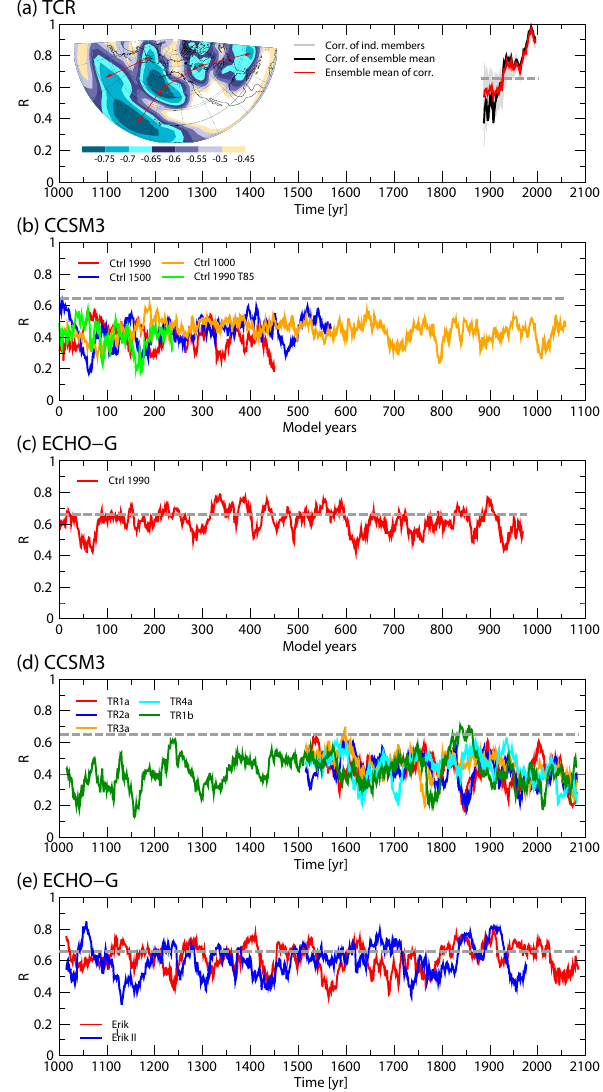
Fig. 4. As Fig. 3, but for the Pacific (see inset in a